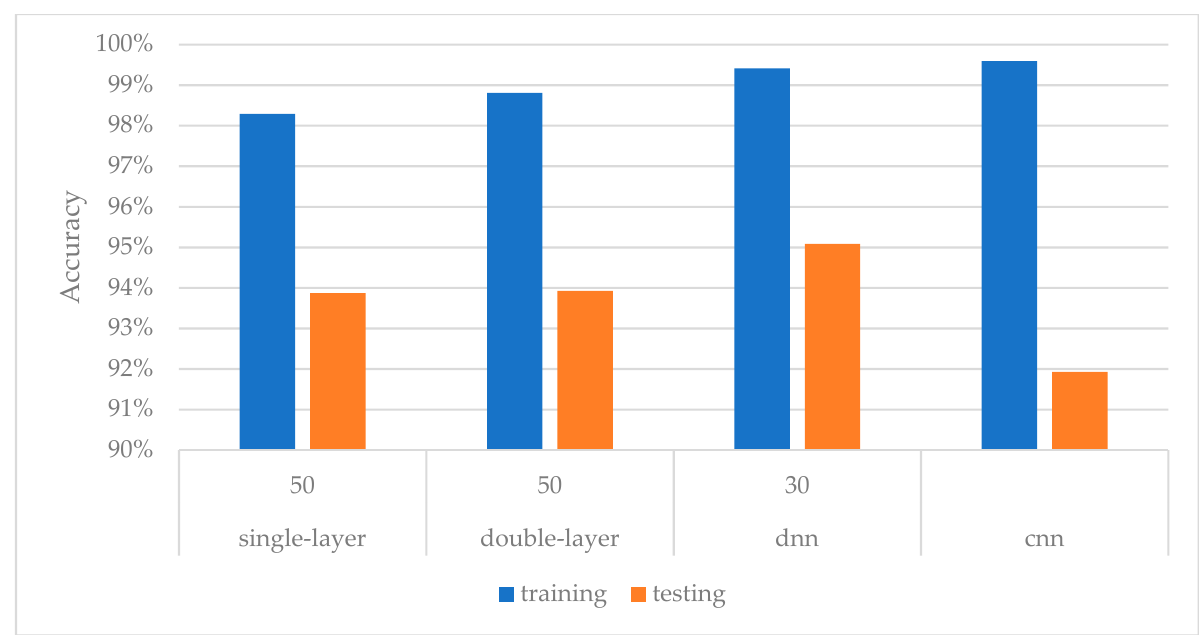
Figure 7. Scenario comparison among the four major NN methods.